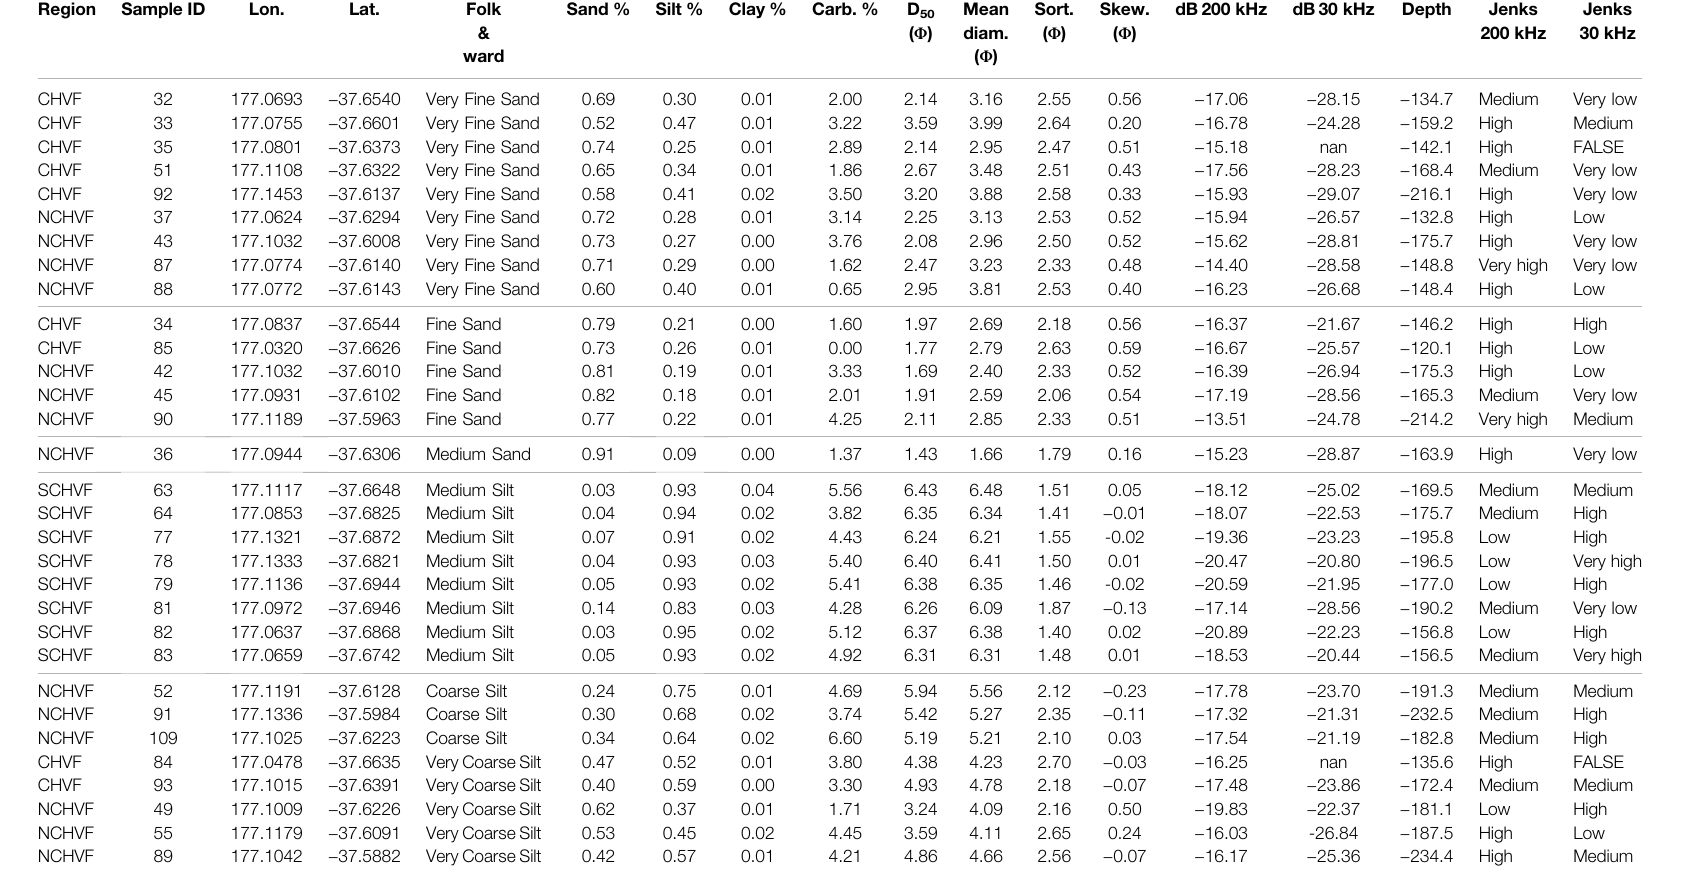
TABLE 2 | Sediment grab Folk and Ward classes, composition, and corresponding Jenks Natural Breaks acoustic classes for both mosaics. Region Sample